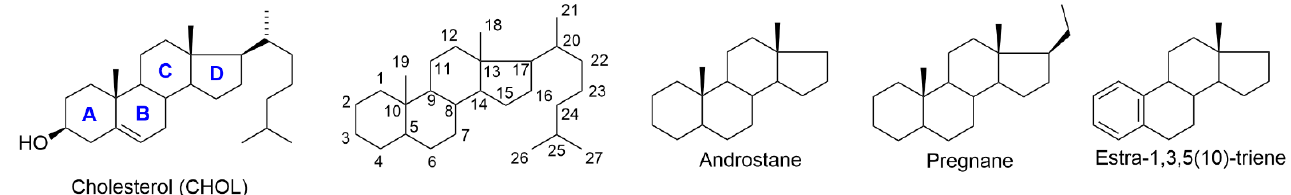
Figure 2. Structure of cholesterol with ring letters (A–D), ring numbering (1–27) and trivial names of basic skeletons relevant for this review.